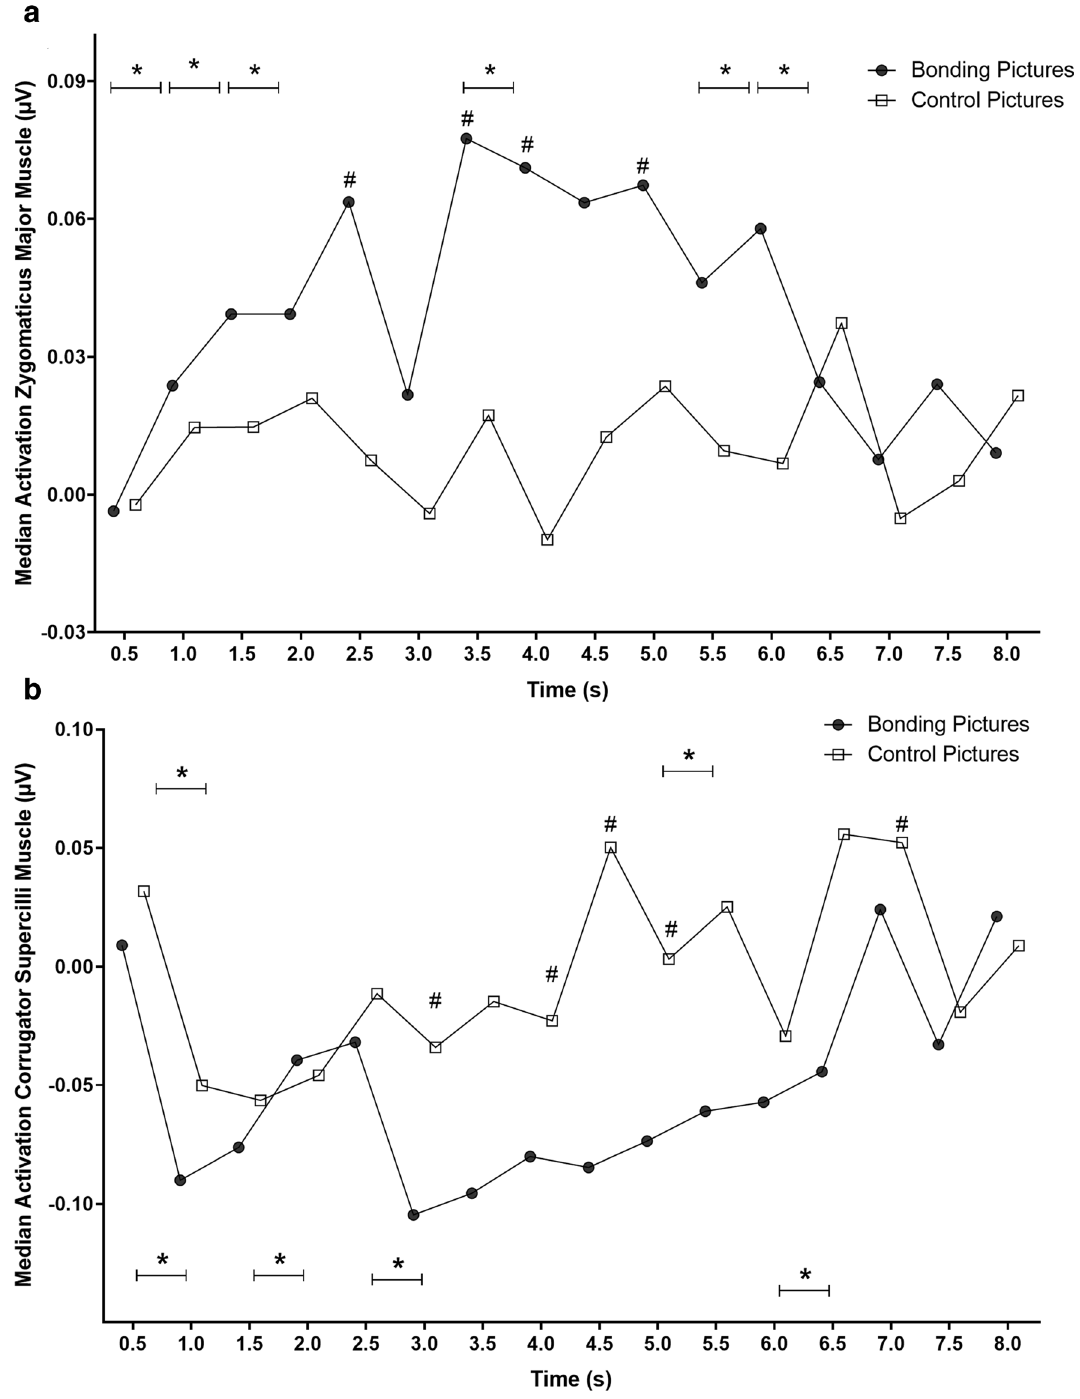
Figure 4. Temporal course of the electromyographic activities (EMG) of the zygomaticus major and corrugator supercilli muscles in study 1. Note The pictures were displayed on the screen between 0 and 4 s. From 4 s to the end, the intertrial interval occurs. Note that EMG activities are sustained throughout the trial. ( a ) Asterisks on the top of the plot represent differences in consecutive time bins for bonding pictures. ( b ) Asterisks on the top of the plot indicate differences in consecutive time bins for control pictures; asterisks at the bottom of the plot indicate differences in consecutive time bins for bonding pictures. #p < 0.05 represents significant differences between conditions. *p < 0.05 represents significant differences within